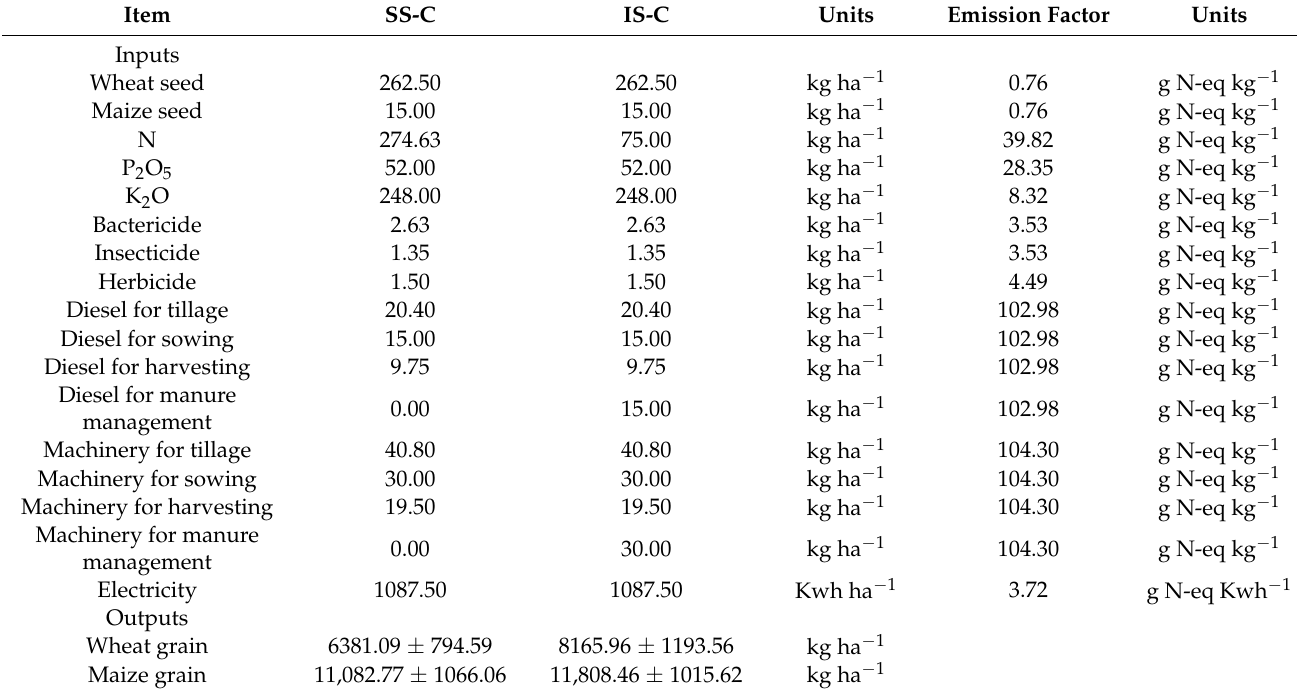
Table 1. Inputs and outputs for crop production, SS-C is the crop production system of separated system and IS-C is the crop production subsystem of integrated